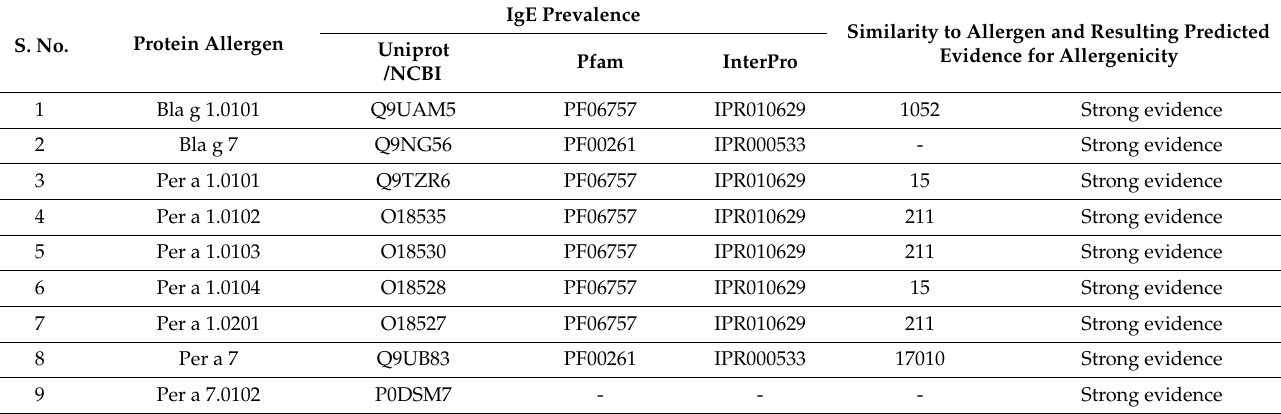
Table 4. Protein allergenicity potential predictions (AllerCatPro 2.0 Results).